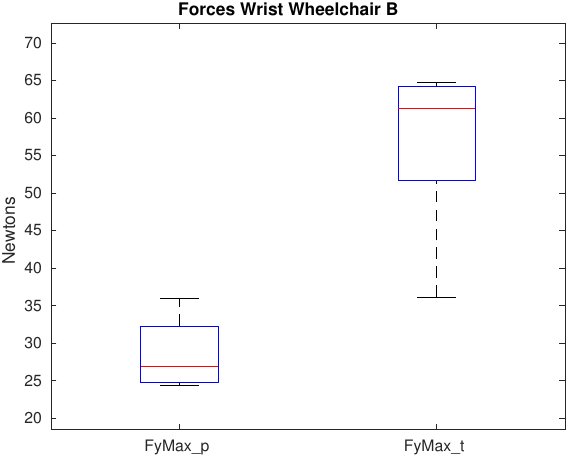
Figure 9. Forces and moments that show significance on the wrist between paraplegics and tetraplegics when propelling wheelchair A. MFyMax shows the maximum lateral force and MxMin shows the minimum radial moment on the wrist. In all cases, the values for paraplegics (_p) and tetraplegics (_t) are shown.